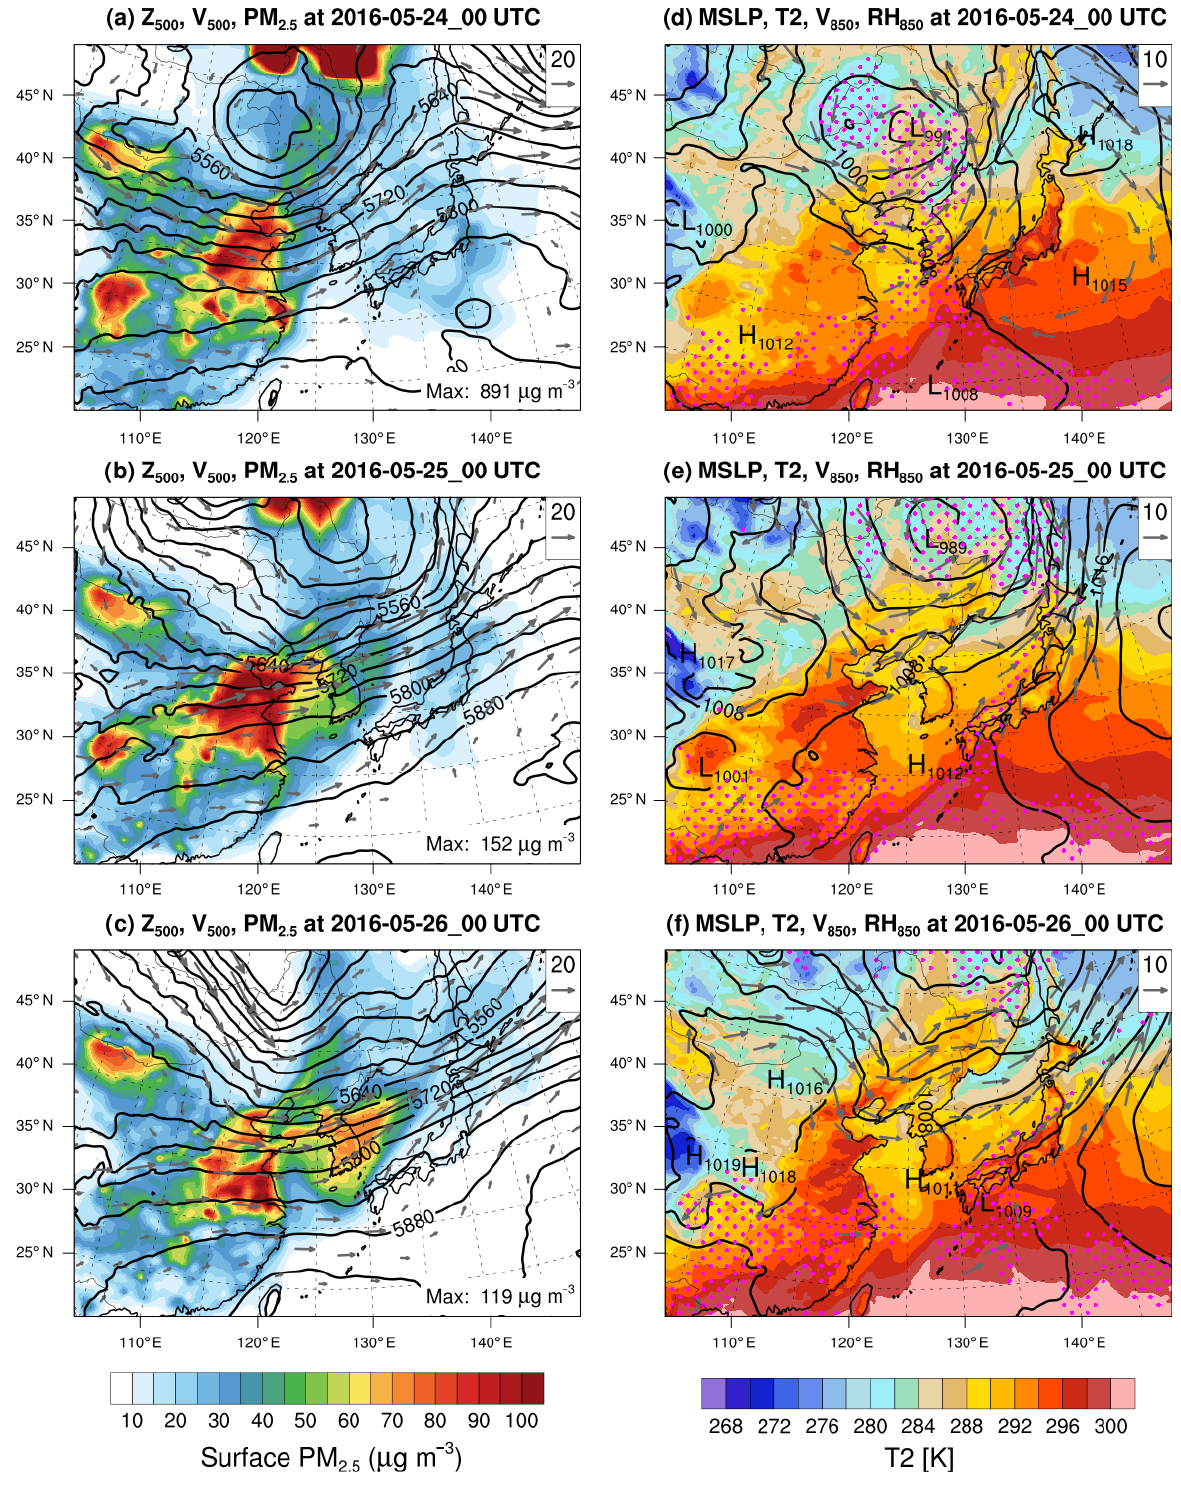
Figure 15. The GSI 3D-Var analyses at 27km resolution in domain 1 in the ALL experiment for 3d from 24 to 26 May 2016 at 00:00UTC (top to bottom). (a–c) The horizontal distribution of surface PM 2 . 5 (µgm − 3 ; filled), geopotential height (contours every 40m), and horizontal winds (ms − 1 ; gray vectors) at 500hPa illustrates that the long-range transport of air pollution from China causes the heavy pollution over South Korea. (d–f) Mean sea level pressure (contours every 4hPa), 2m temperature (K; filled), relative humidity ( > 90%; pink dots), and horizontal winds (ms − 1 ; gray vectors) at 850hPa represent the weather system in the low troposphere at the same